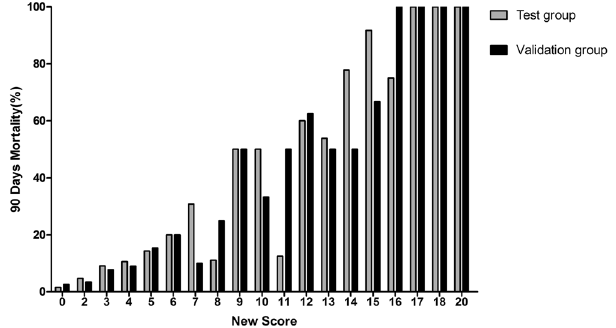
Figure 2. Corresponding 90-day morality for each score between test group and validation